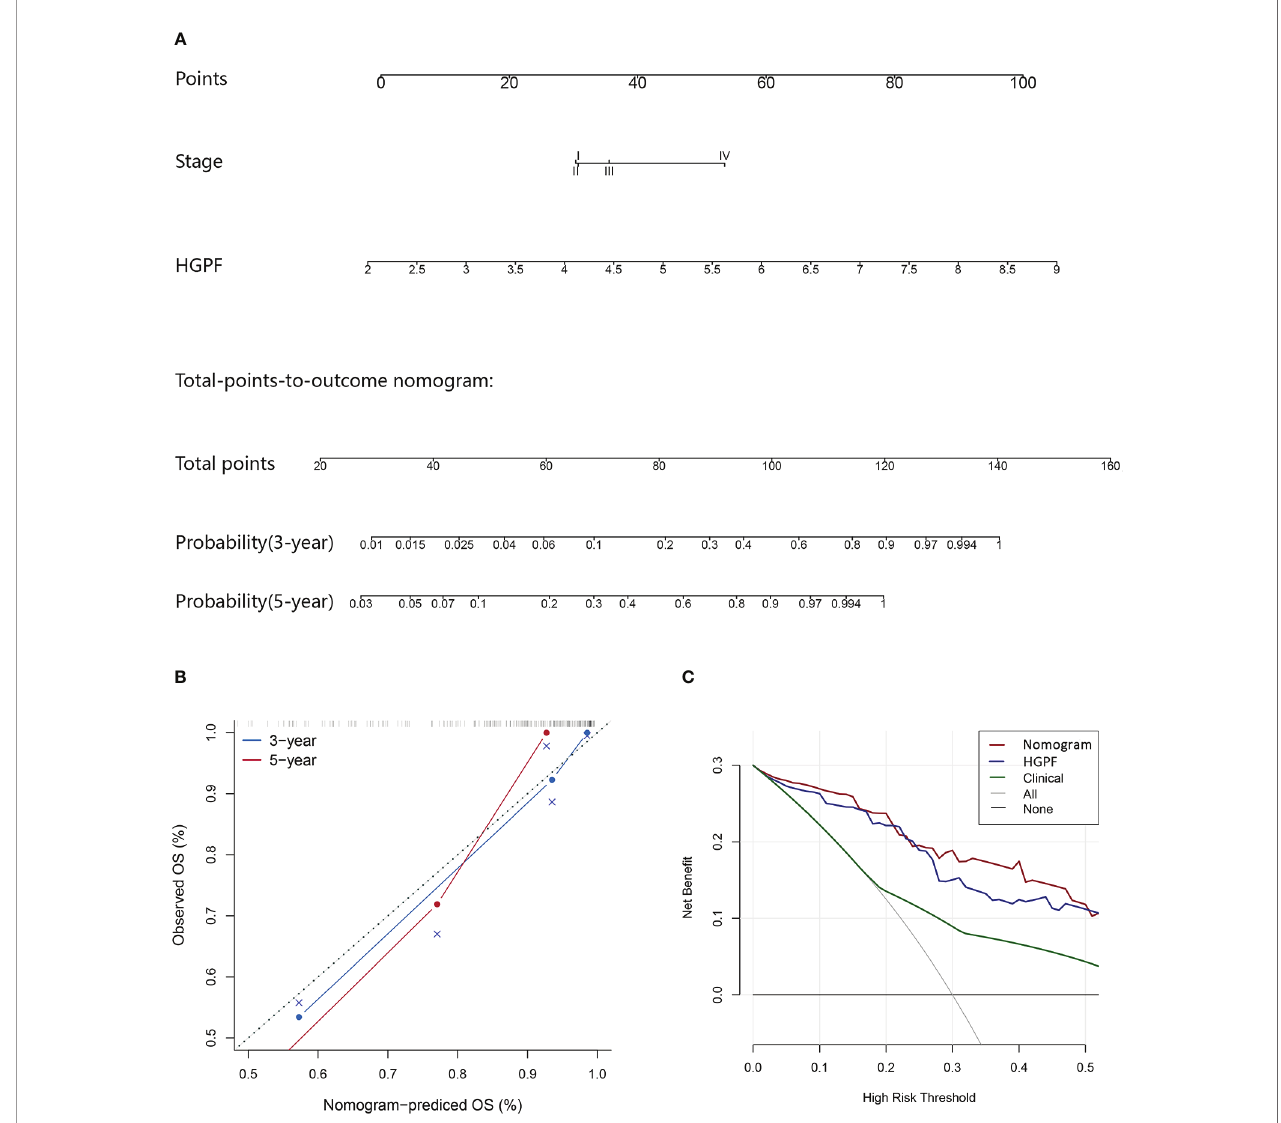
FIGURE 8 | Evaluation of the predictive performance of the integrated prognostic model. (A) The prognostic nomogram incorporates the histopathological-genomic prognosis factor (HGPF) and tumor stage of patients. (B) Assessment of nomogram prediction accuracy. (C) Decision curve analysis (DCA) shows the predictive effects of different models. The integrated model has a better prediction ability than